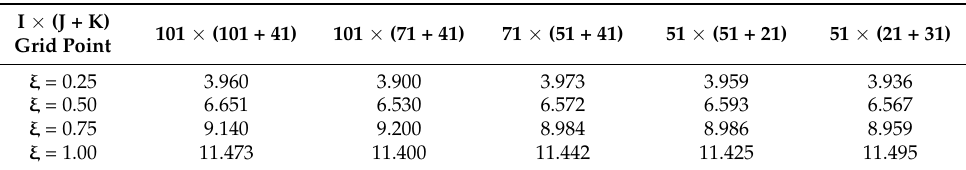
Table 1. Stability of the calculation from the mesh variations’ evaporating rate the water film.